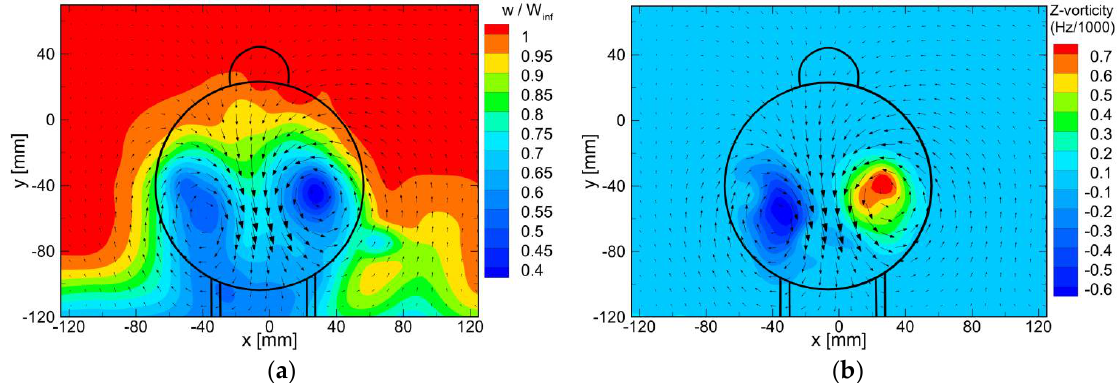
Figure 2. Time-averaged streamwise velocity component ( a ) and streamwise vorticity component ( b ) at plane z/D = 1. One every three vectors is shown both in the x- and in the